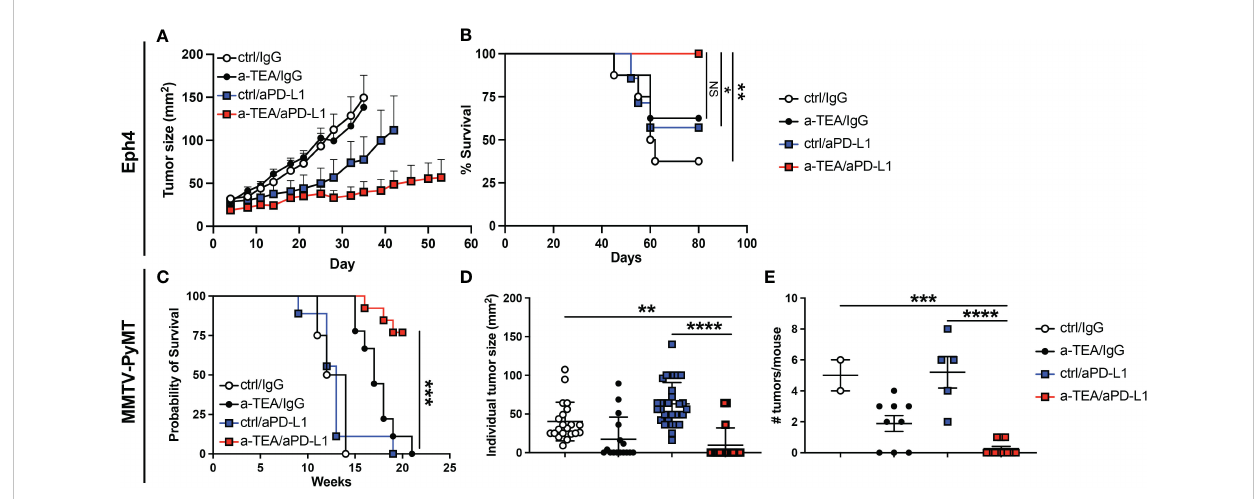
FIGURE 3 Combined a-TEA-LS plus aPD-L1 ICB reduces tumor burden and extends survival in Eph4 1424 tumor-bearing mice and in the PyMT-MMTV Tg model of spontaneously arising mammary carcinoma. (A, B) Eph4 1424 mammary carcinoma tumor-bearing mice were treated with control diet, IgG (ctrl Ab), a-TEA- LS, and/or aPD-L1 and then (A) tumor growth (mean+SD) and (B) survival were determined (n=8/group). C-E) PyMT-MMTV Tg mice were treated with control diet/IgG (n=4), a-TEA-LS/IgG (n=9), ctrl/aPD-L1 (n=8), or a-TEA-LS/aPD-L1 (n=13) starting at 6 weeks of age. (C) Survival, (D) individual tumor size (left panel), and (E) number of tumors per mouse (all at week 13) was determined. Graphs depict the mean+/-SEM. (B, D) *P<0.05, **P<0.01, ***P<0.001 by Log-rank test; (E) **P<0.01, ***P<0.001, ****P<0.0001 by 1-way ANOVA. NS, not signi fi